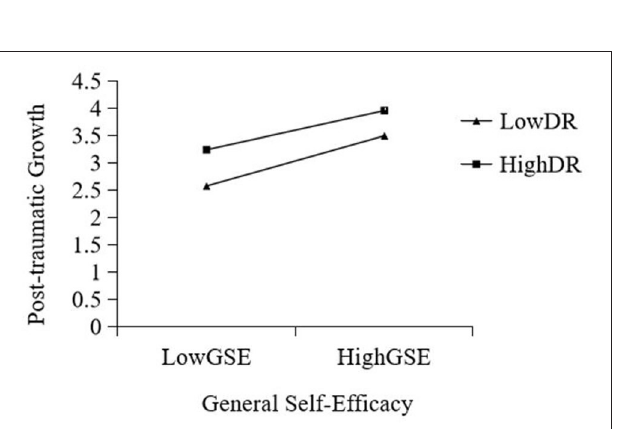
FIGURE 3 | Interactive effects of PTG and DR on PR. DR, deliberate rumination; PTG, posttraumatic